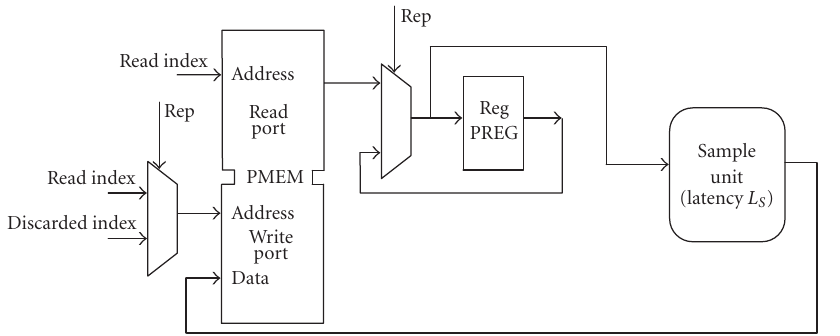
Figure 7: Architecture of sample